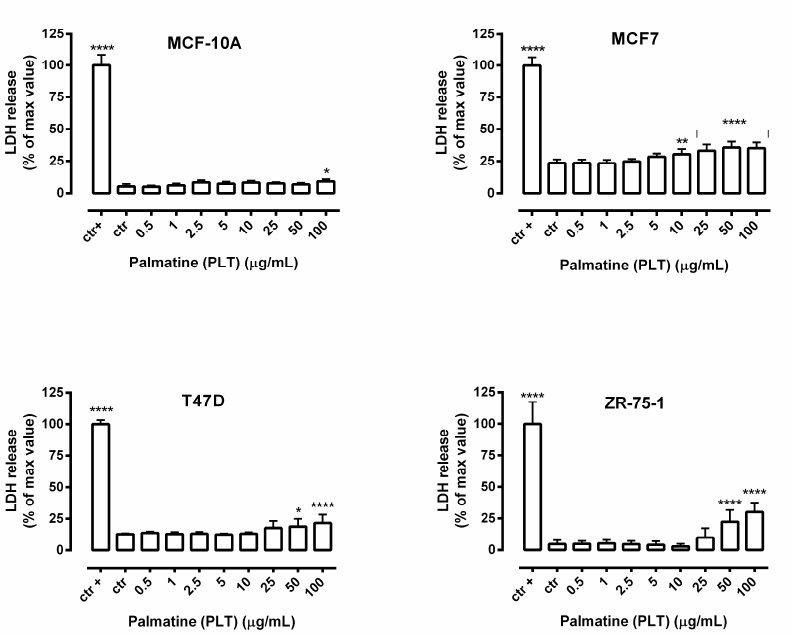
Figure 4. Cytotoxicity of palmatine (PLT) to normal human breast epithelial cells (MCF-10A) and breast cancer cells (MCF7, T47D, and ZR-75-1). Lactate dehydrogenase ELISA kit was used to quantify cytotoxicity by measuring LDH activity released from damaged cells. Normal breast epithelial cells and breast cancer cells were incubated for 72 h alone or in the presence of PLT (0.5–100 µ g/mL). The results are presented as the percentage in LDH release to the medium by treated cells vs. cells grown in control medium (ctr) and cells treated with lysis buffer (ctr+). Data are presented as mean ± SEM at each concentration. * p < 0.05; ** p < 0.01 and **** p < 0,0001 vs. control group (Tukey’s test), n = 24 from three independent experiments.